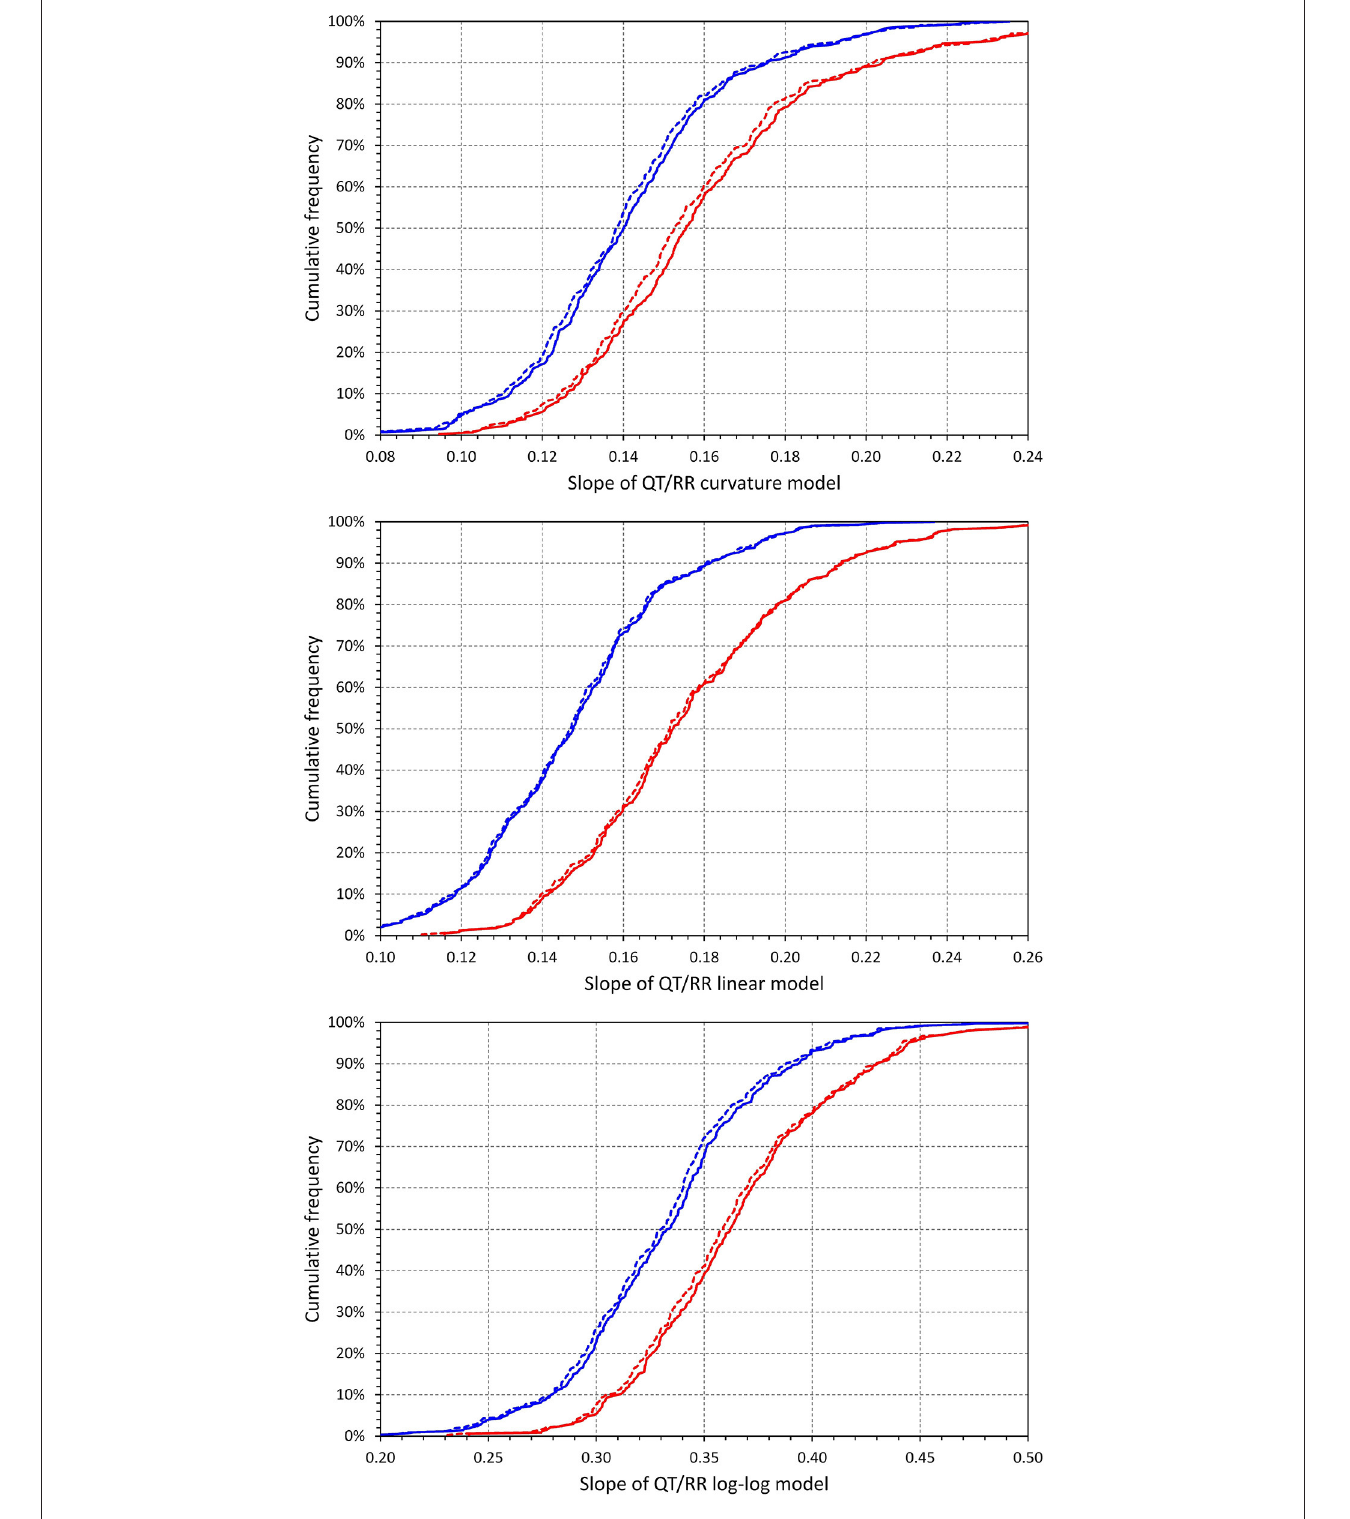
FIGURE 6 | Cumulative distributions of intra-subject slopes of QT/RR H regression models for the curvature model (top panel), linear model (middle panel), and log-log model (bottom panel). In each of the panels, the red and blue lines correspond to females and males, respectively; the full and dashed lines correspond to the time-based and interval-based QT/RR hysteresis models,